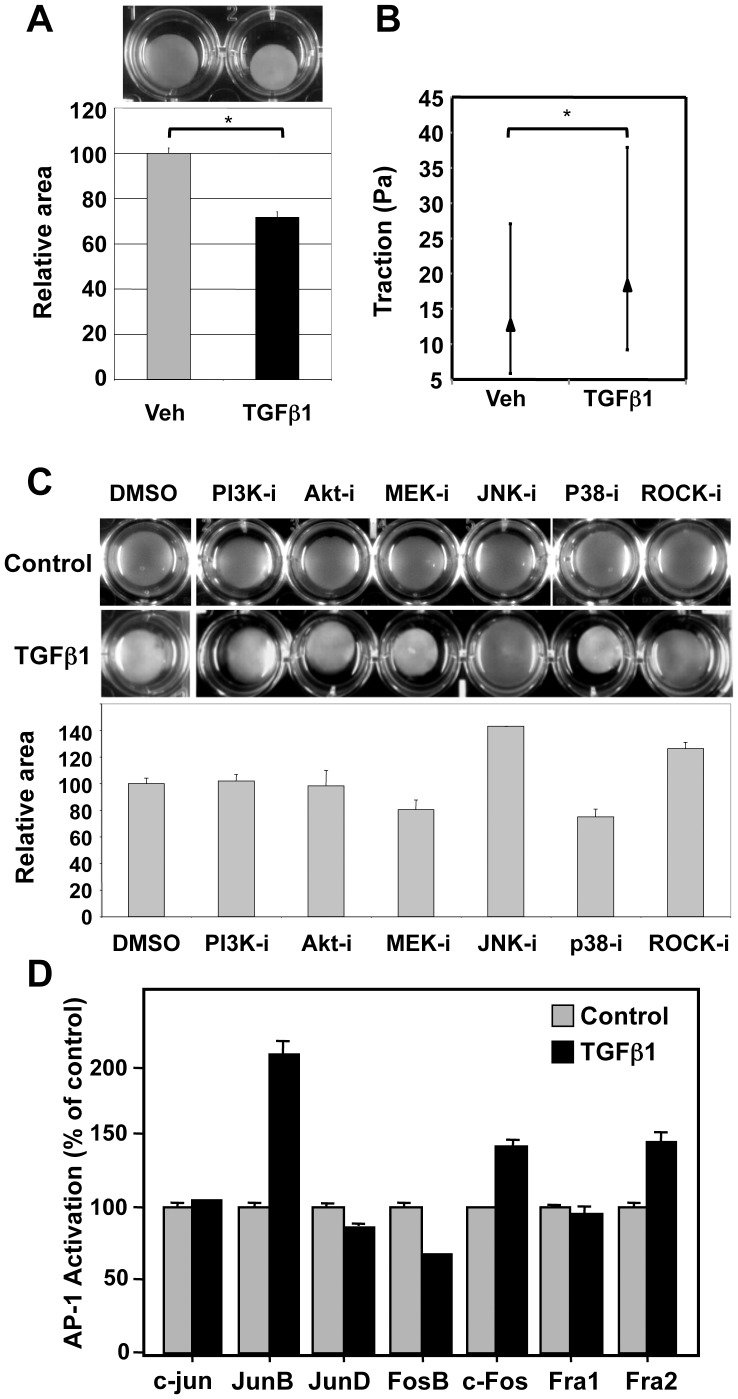
TGFβ1induces contractility in bladder smooth muscle cells (BSMC).(A) Human bladder smooth muscle cells were seeded in collagen gels and treated for 24 h with vehicle (Veh) or 2.5 ng/ml TGFβ1, after which the gels were released from the sides of the well and the resulting decrease in surface area monitored microscopically (top) and quantified (bottom). *p<0.05, t-test. The area of the gel under control conditions is set to 100%. (B) Whisker plot of results from traction force microscopy of BSMC showing an increase in cell traction forces exerted with TGFβ1 treatment. The contractile response, measured quantitatively as enhanced traction (see Methods) was statistically significant (*p<0.05, Kruskal-Wallis test). The median value of traction and the interquartile range for both groups is shown. (C) BSMC were treated for 30 min with inhibitors targeting the PI3-kinase/Akt (PI3K-i, Akt-i) mitogen-activated protein kinases (MEK-i, p38-i, JNK-i) or Rho-kinase (ROCK-i), followed by treatment with vehicle (Control, upper panel of wells) or 2.5 ng/ml TGFβ1 (lower panel) for 24 h and were monitored for changes in gel contractility. Inhibition of signaling via the JNK and ROCK axes abrogated TGFβ1-induced gel contraction. Quantification of changes in gel surface area for the various inhibitors under conditions of TGFβ1 treatment is indicated. (D) A transcription factor ELISA was carried out to assess differences in DNA-binding activities of members of the AP-1 family of transcription factors, using nuclear extracts prepared from BSMC treated with 2.5 ng/ml TGFβ1 for 24 h, or control cells. Fold changes are expressed relative to control which is set to 100%.